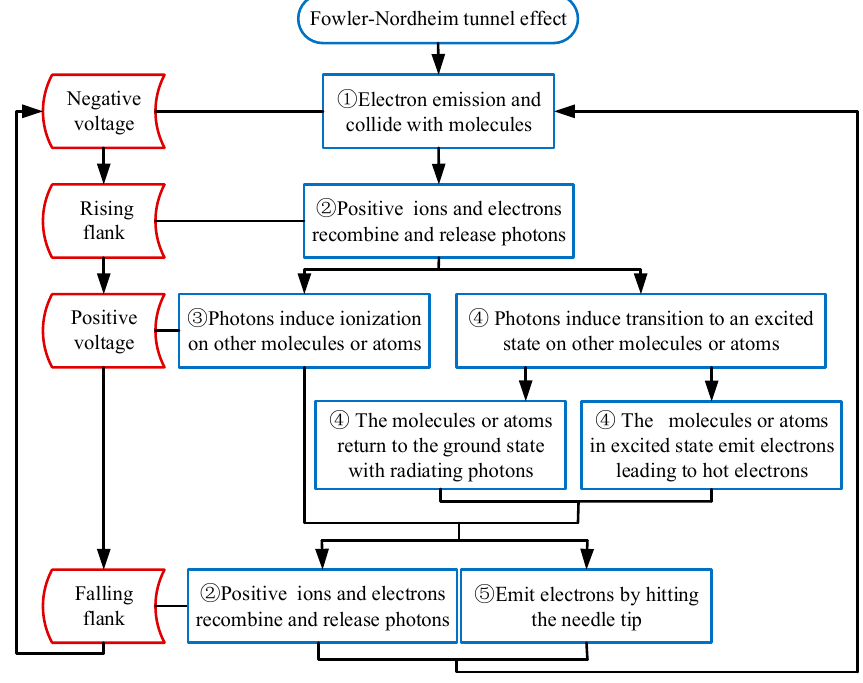
Figure 10. The flow chart of the process in Figure 9.